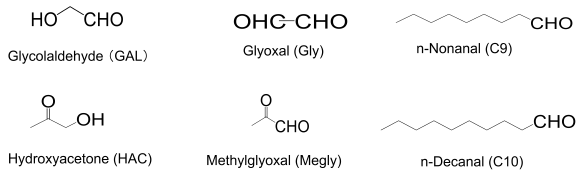
Fig. 1. Chemical structures of carbonyl compounds determined in Fig. 2 this study.